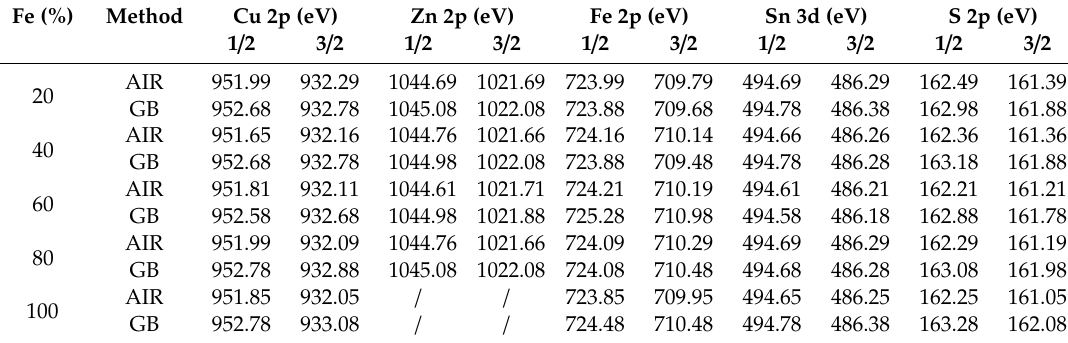
Table 1. Calculated main peak positions in the XPS spectra of the high-resolution core level for Cu 2p, Zn 2p, Fe 2p, Sn 3d, and S 2p regions of the 20%, 40%, 60%, 80%, and 100% C(Z,F)TS thin films, made in glovebox and